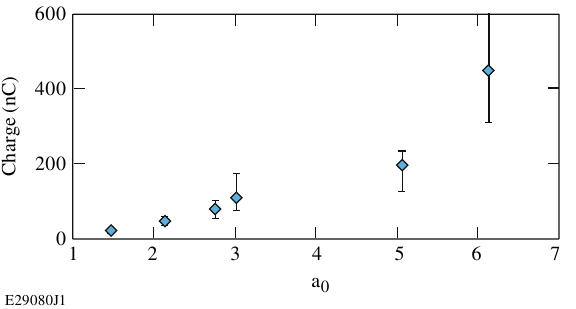
Figure 4. Electron beam charge versus a 0 for a 6-mm-diameter nozzle operating at a plasma density of 5 × 10 18 cm −3